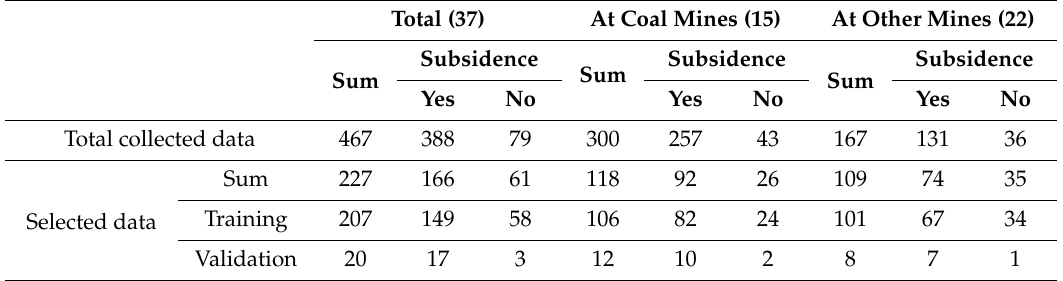
Table 1. Number of data